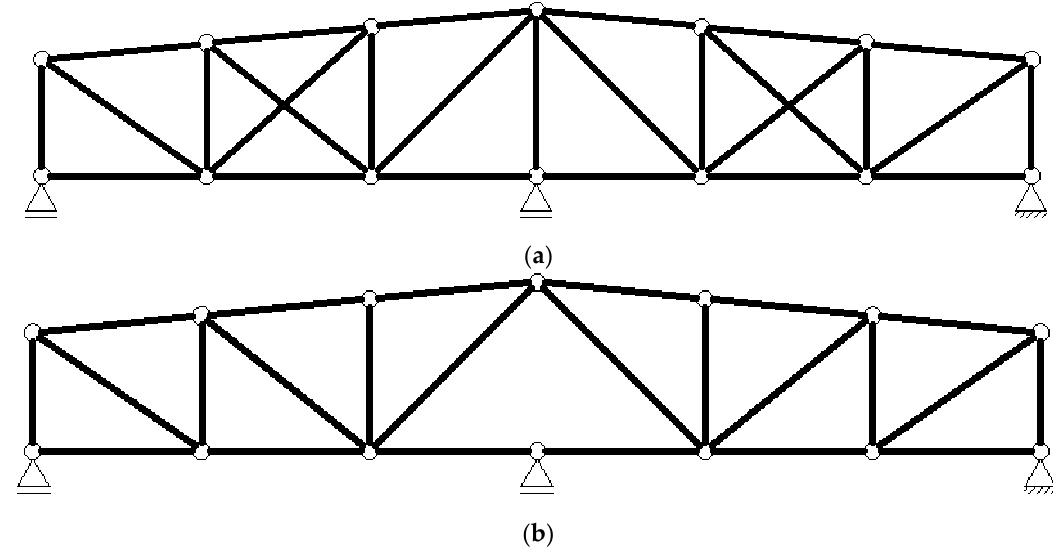
Figure 4. Change in the static scheme of truss “A” along with the fire duration: ( a ) t fi = 20.05 min (1203 s) and ( b ) t fi = 29.2 min (1752 s).